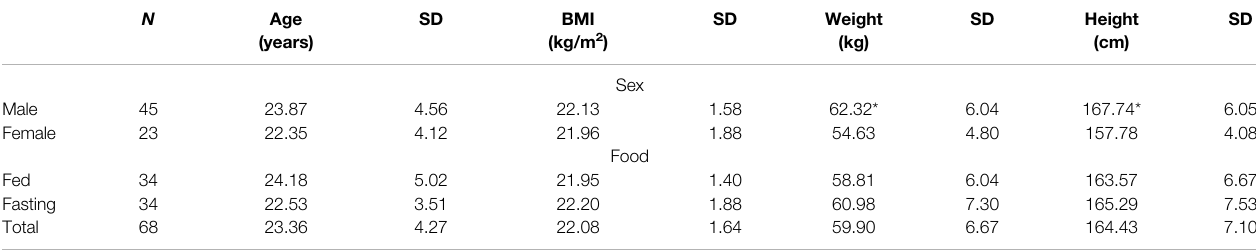
BMI , body mass index; SD , standard deviation * p < 0.05 after t -test